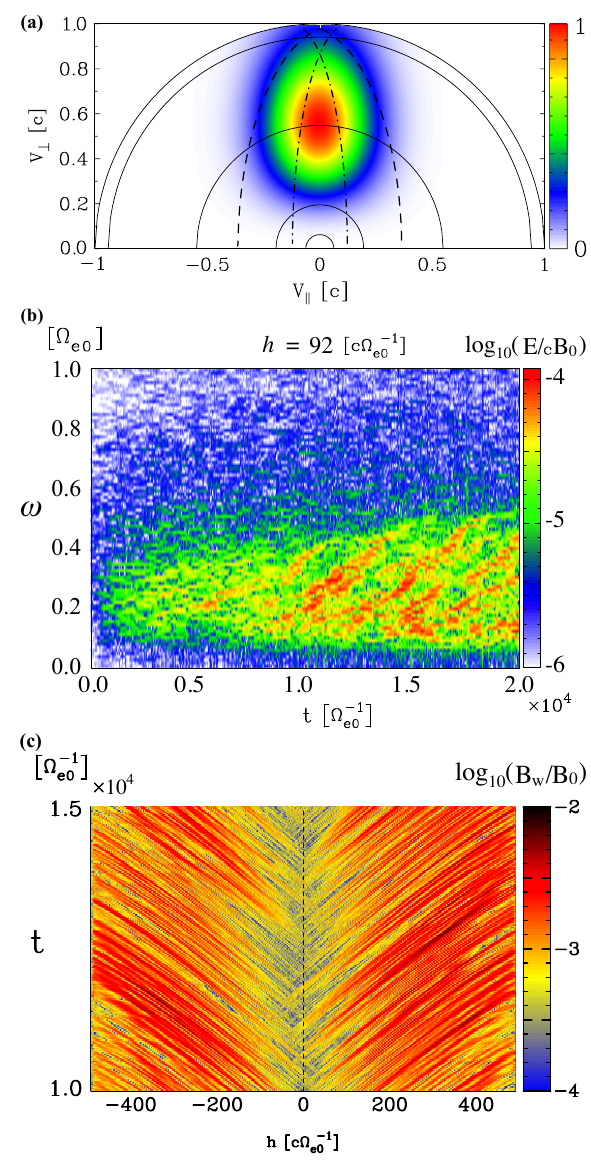
Fig. 2. Simulation results of the electron hybrid code used for the pseudo-observations of the WPIA. (a) The initial velocity dis- tribution of energetic electrons assumed at the magnetic equator. Dashed and dash-dotted lines respectively denote resonance ellipses of ω = 0 . 2 and 0.5 (cid:127) e0 (after Summers et al., 1998). The five solid semicircles represent constant energy contours of 1keV, 10keV, 100keV, and 1MeV, and the speed of light. (b) Spectrogram ob- served at the fixed point h = 92 c(cid:127) − 1 in the Northern Hemisphere e0 of the simulation system. (c) Time evolution of the spatial profile of the wave magnetic field